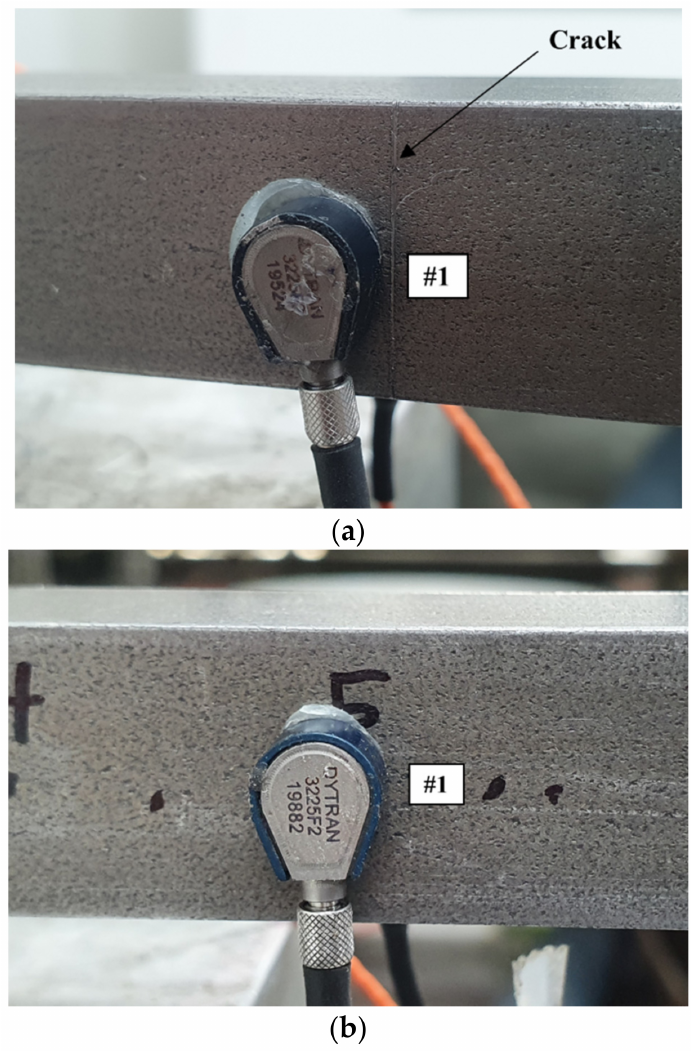
Figure 4. Attachment location of sensor #1: ( a ) specimen with crack and ( b ) specimen without